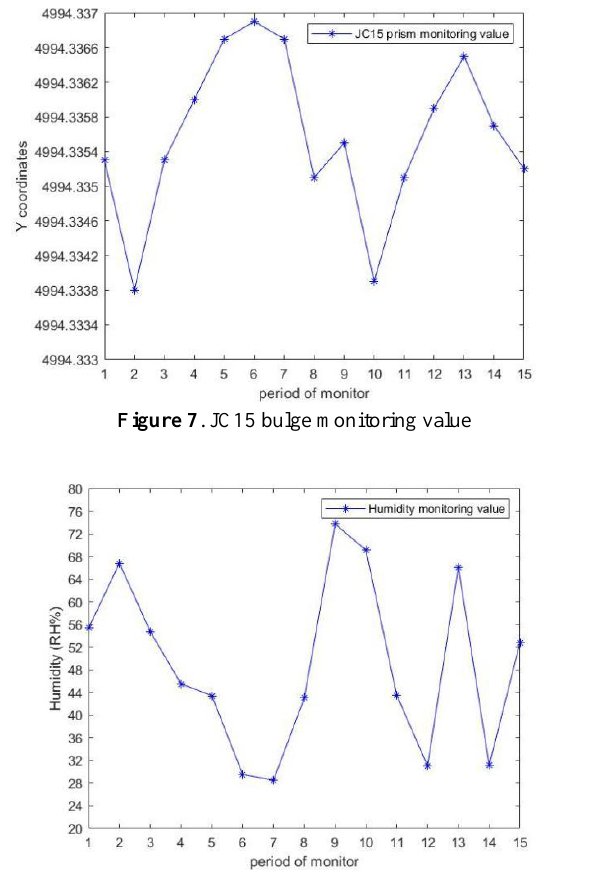
Figure 8 . Humidity monitoring